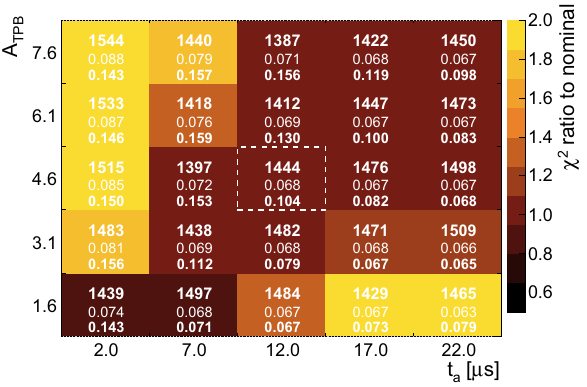
Fig. 8 Each box corresponds to a fit where A T PB and t a are fixed to the value indicated on the axis. The box in the very center (light dashed outline) corresponds to the nominal fit where A T PB and t a are fixed to the best fit values from [25]. The values on the axes span the range from − 2 σ to + 2 σ using the parameter uncertainties from [25]. A measure for the typical relative difference between model and data is shown on the color scale (see text for an explanation of how this is calculated). The fit-out values for τ t (in units of ns), ν AP3 , and R TPB are printed in each box, in that order from top to bottom